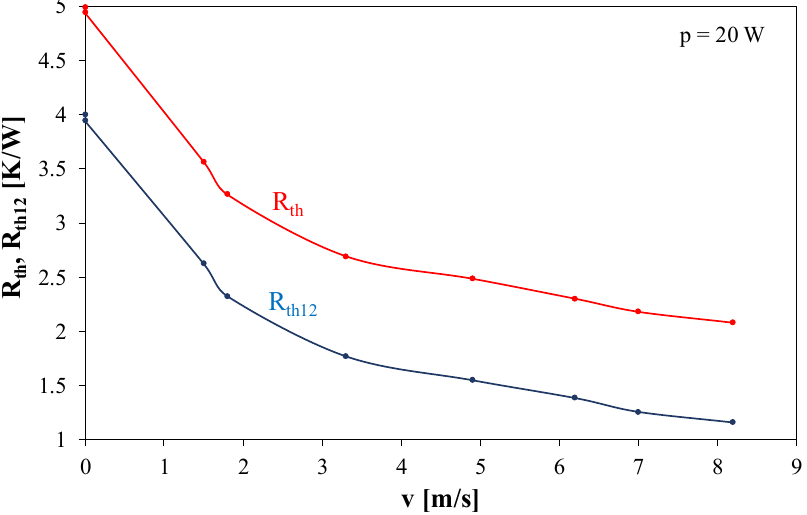
Figure 17. Dependences of thermal resistance of transistor M 1 and transfer thermal resistance between transistors on the air flow speed.